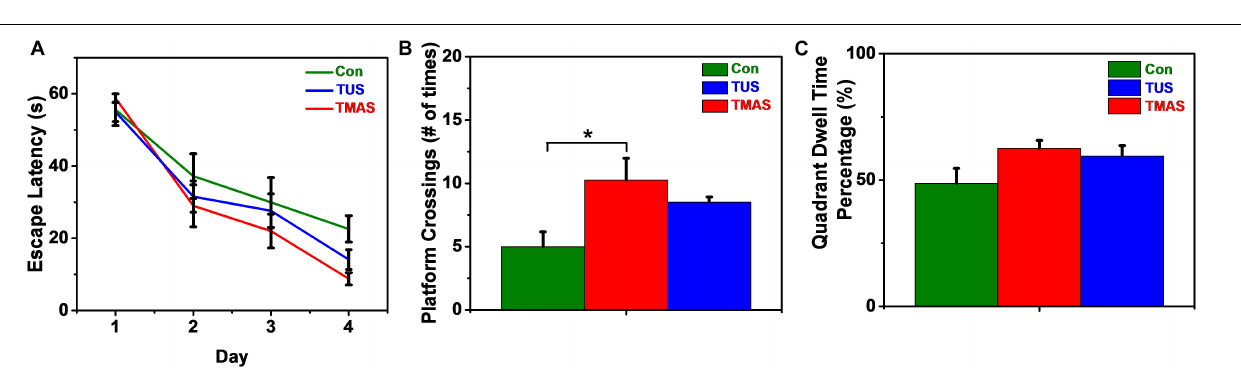
FIGURE 10 | MWM training and test results of the healthy mice ( n = 3). (A) Escape latencies during training days. (B) Platform crossings on probing test day. (C) Percentage of duration spent in the target quadrant. ∗ p < 0.05.